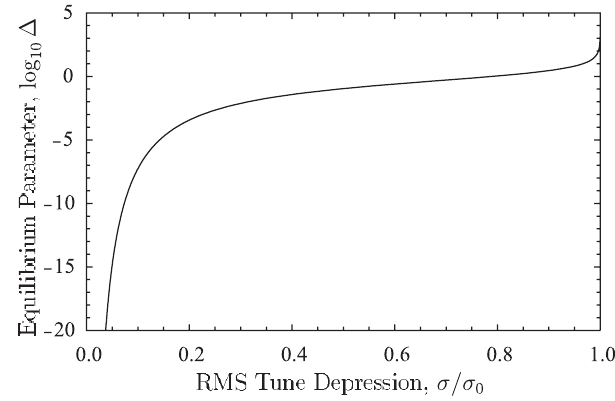
FIG. 3. Dimensionless thermal equilibrium parameter (cid:3) ¼ (cid:1) 1 plotted versus rms-equivalent beam tune (cid:1) 2 c 2 k 2 = ^ ! 2 (cid:2) 3 p (cid:1) 0 b b as calculated from Eq. depression (cid:7)=(cid:7) 0